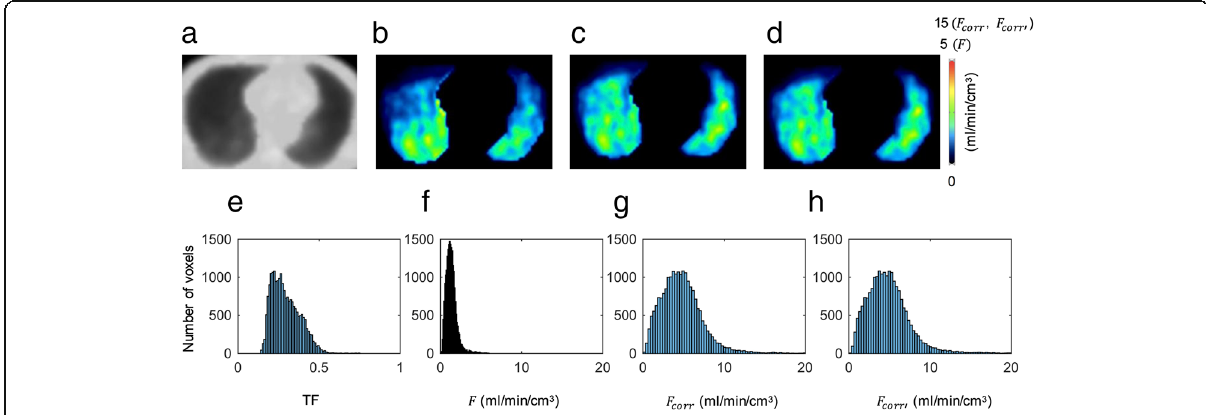
Fig. 3 Transmission image ( a ), PBF image without TF correction ( b ), PBF image with TF and blood volume correction ( c ), PBF with TF and without blood volume correction ( d ), histograms of TF ( e ), PBF image without TF correction ( f ), PBF image with TF and blood volume correction ( g ), and PBF image with TF and without blood volume correction (h ) in patient 1, who had right upper lobe lung cancer